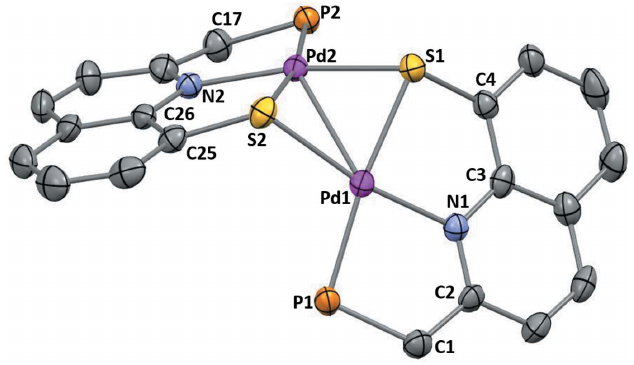
Figure 3 Detail of the molecular structure of 2 2+ , showing the main atom- numbering scheme and displacement ellipsoids at the 50% probability level. H atoms and i Pr groups have been omitted for